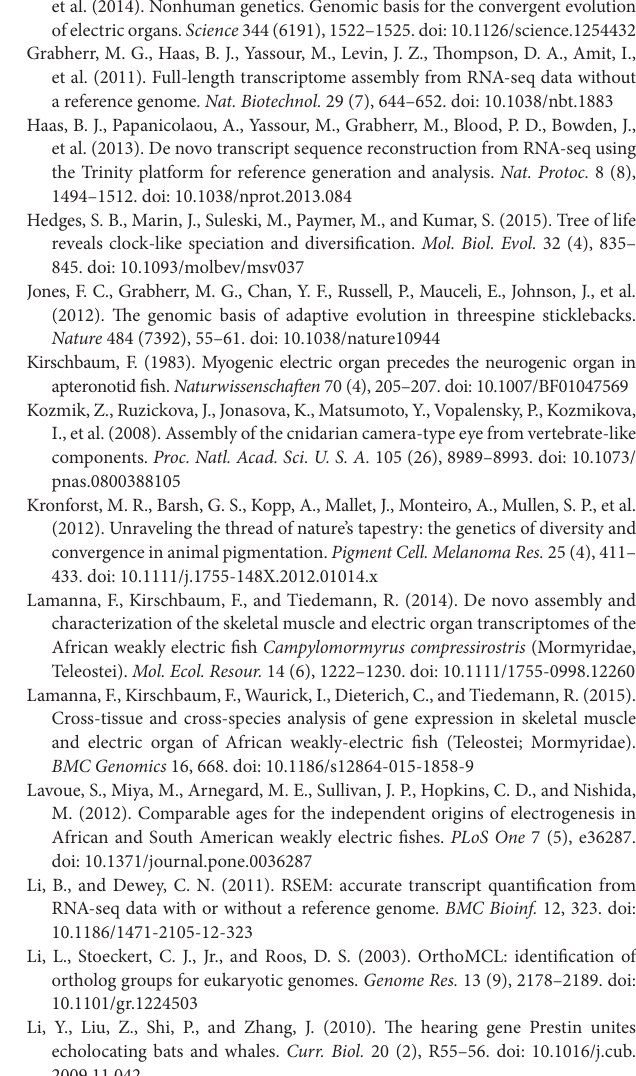
FIGURE S5 | Comparative analysis of Spearman’s correlation coefficient between 12 expression clusters in different tissues. EO, SM, and E/S represent the correlation coefficients between any two expression profiles of the EOs, SMs, and between EO and SM, respectively. * denotes p < 0.05; ** p < 0.01; *** p < 0.001. FIGURE S6 | Comparative analysis of DEGs among five electric fishes. FIGURE S7 | Log2 fold expression change correlation between different species. TABLE S1 | The detailed information of raw data used for this study. TABLE S2 | The GO and KEGG pathway enrichment analyses for DEGs between the SM and EO in each electric fish. TABLE S3 | Fisher’s exact test for statistically significant overrepresentations of GO categories and KEGG pathways of shared DEGs among different